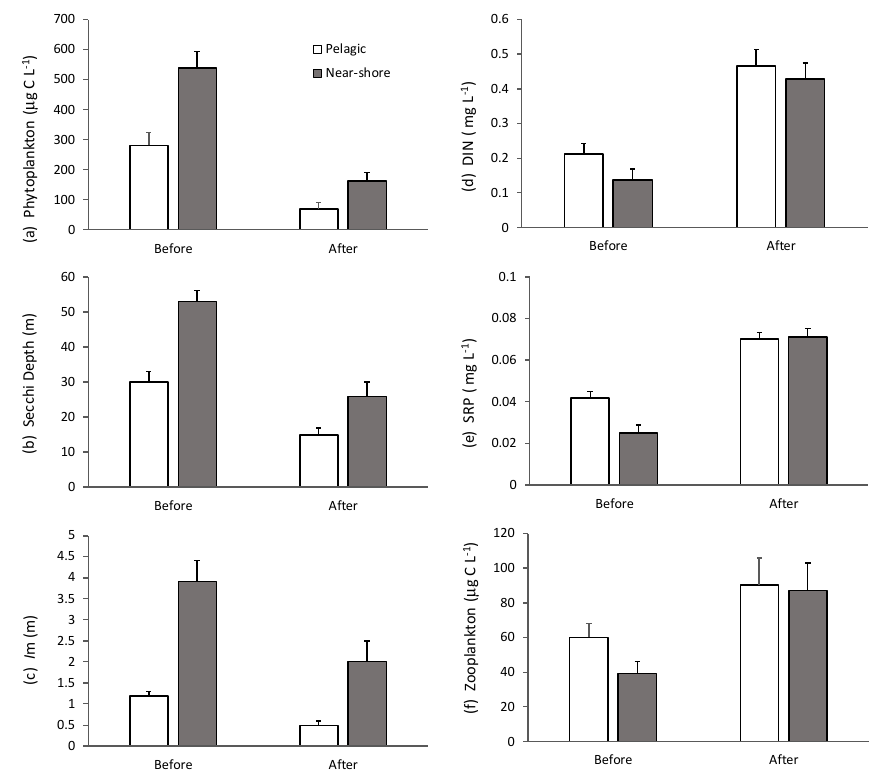
Figure 2. Conditions in Lake Okeechobee before and after the hurricanes of 2004–2005. Data are presented as means with standard error bars. In every case, the differences are statistically significant at p < 0.05.